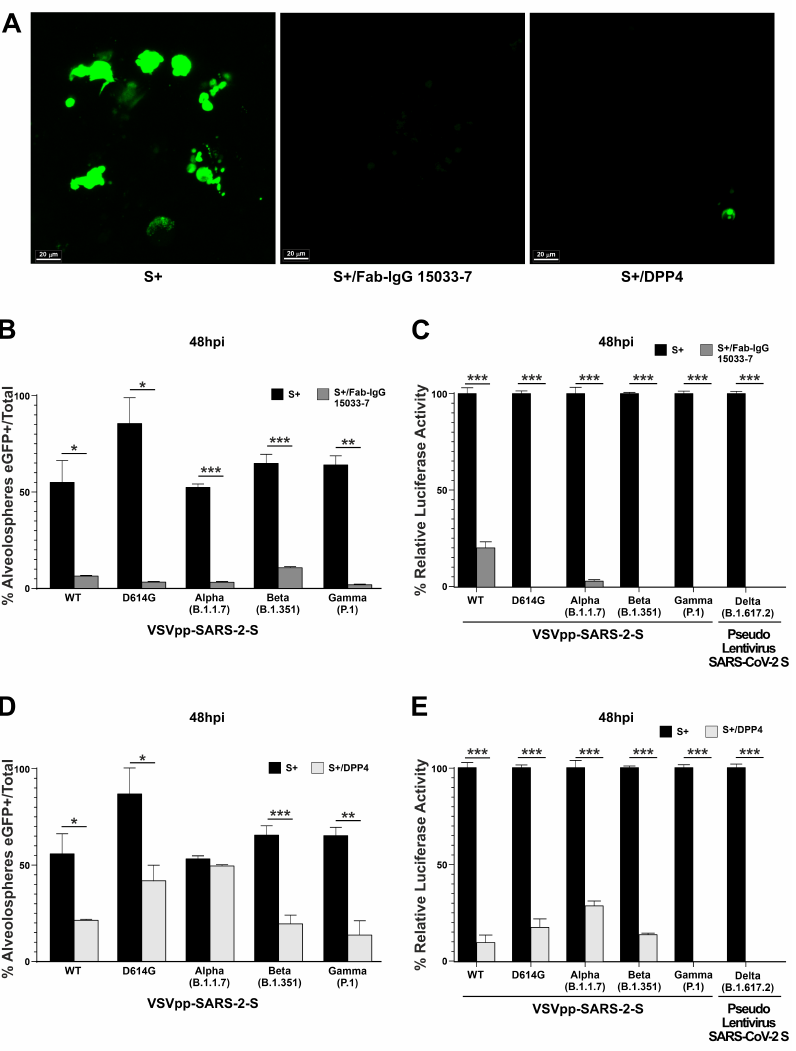
Figure 4. Fab-IgG 15033-7 and DPP4 270-295 synthetic peptide are able to inhibit pseudotype SARS-2-S